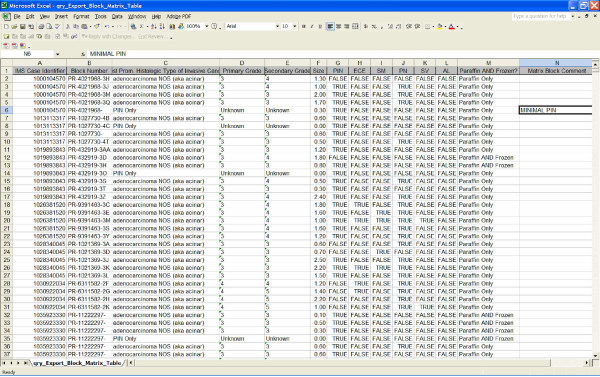
Example of a pre-defined export file. An example of one of the pre-defined export file (prostatectomy block matrix file) in Microsoft Excel.